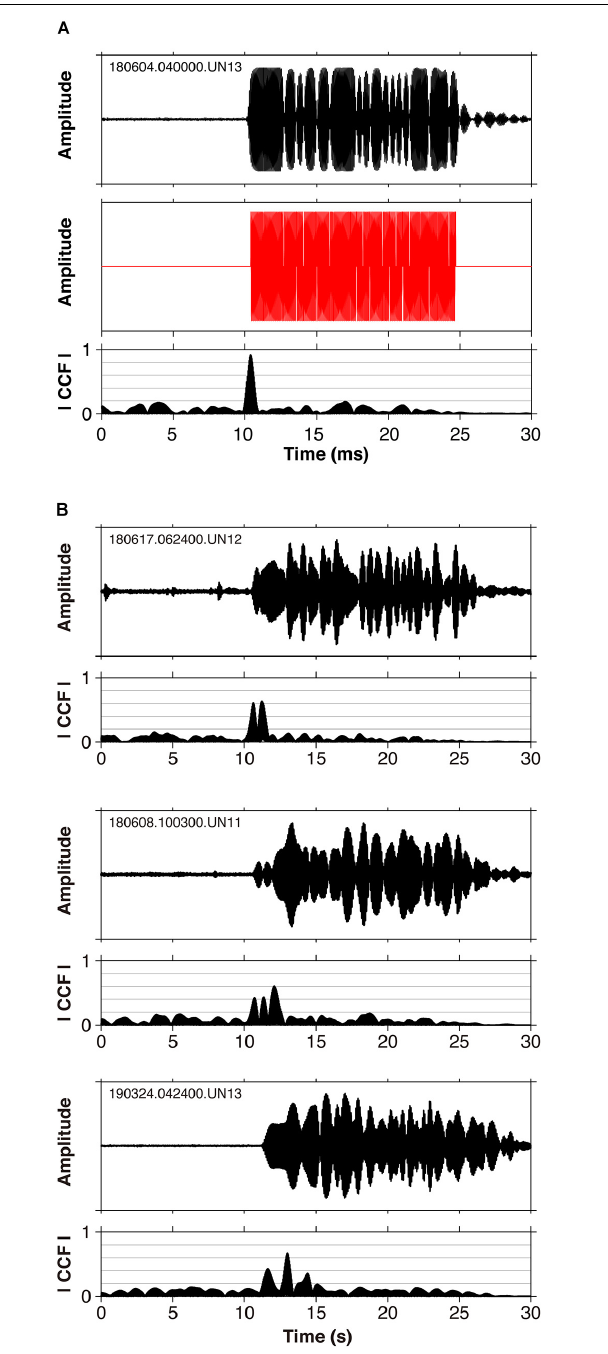
FIGURE 8 | Examples of received acoustic waveform on the buoy-mounted acoustic ranging controller. (A) Waveform with high signal-to-noise ratio. Top: received waveform middle: theoretical transmitted signal from the buoy mounted acoustic transducer, bottom: absolute cross-correlation function (CCF) between the received and transmitted (reference) signals. The maximum value of the cross-correlation function is 0.92. (B) Waveforms with obvious reflected waves. Each noticeable peak of CCF corresponds to the onset of the direct or the reflected waves. Top and middle: reflected waves from the buoy body or the sea bottom are included, bottom: reflected waves from the sea surface are